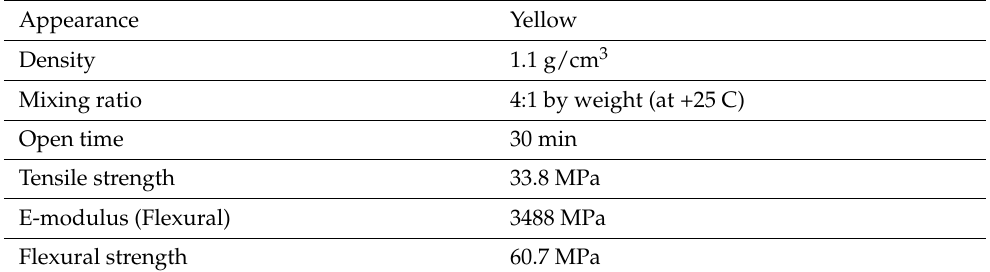
Table 4. Mechanical properties of epoxy adhesive (provided by the